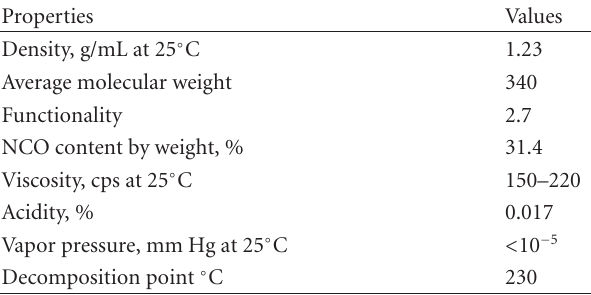
Table 1: Specifications of polymeric isocyanate PAPI 27 [29].